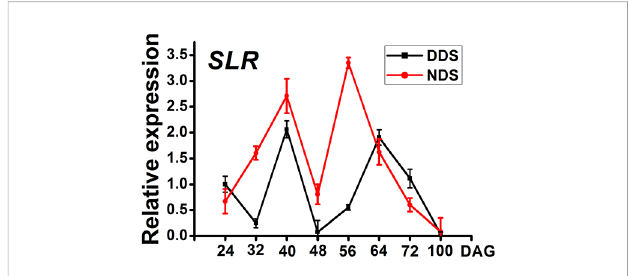
FIGURE 8 A qRT-PCR analysis of the temporal expression in the whole plants containing SLR between DDS and NDS at 24 、 32 、 40 、 56 、 64 、 72 、 100 DAG. Error bars represent mean ± SD (n = 3) where the different letters indicate statistical differences by Duncan ’ s multiple range test (p ≤